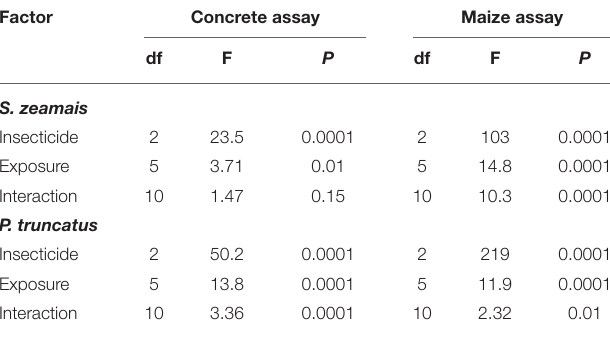
TABLE 3 | Summary of statistical model results for GLM of distance moved by S. zeamais and P. truncatus in the after exposure in the concrete assay and maize assay.